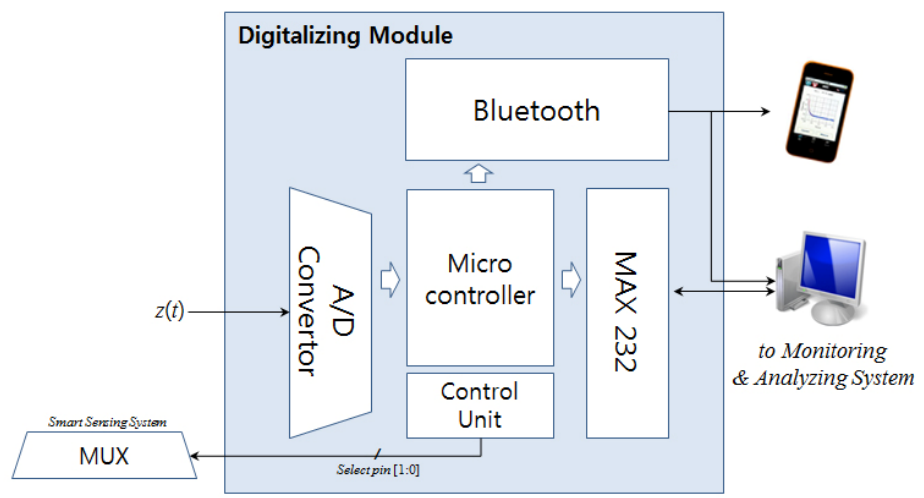
Figure 4. Structure of digitalizing module.